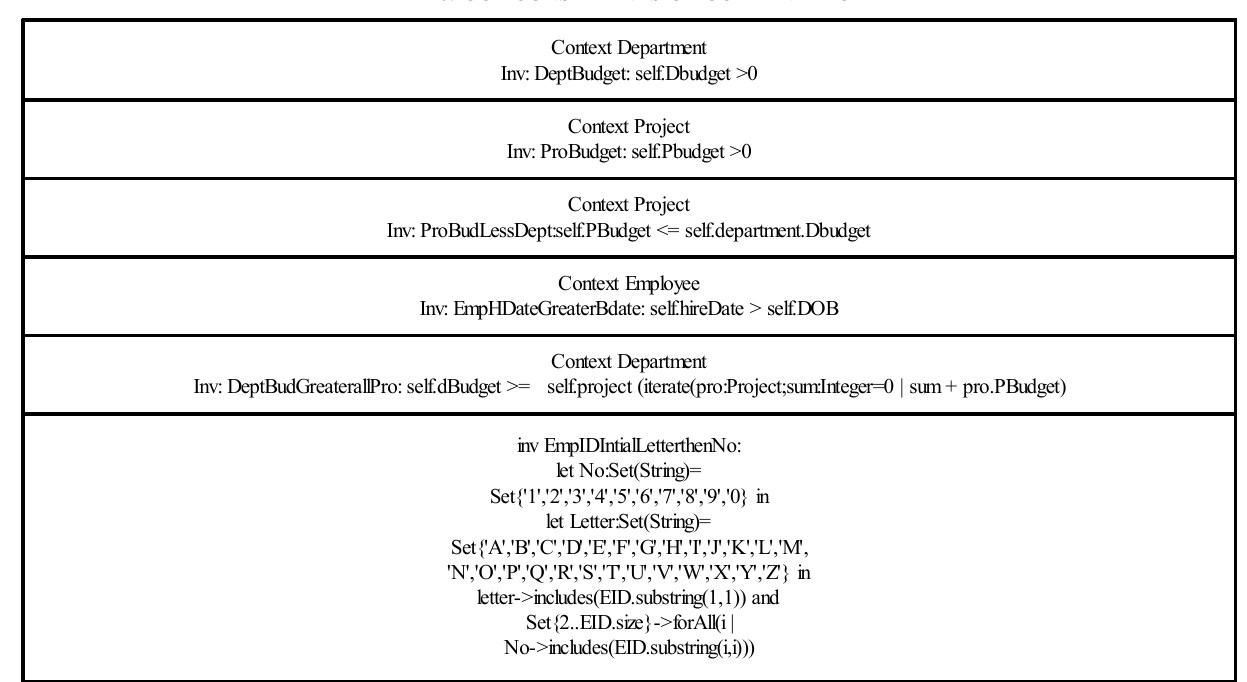
TABLE 6. OCL CONSTRAINTS OF COMPANY